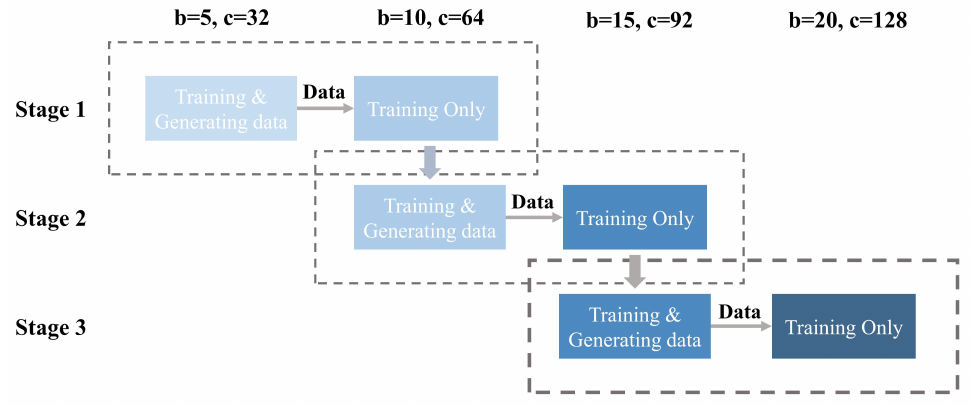
Figure 5. Process of network curriculum learning. Data generated by the shallower network are used to train both the shallow network itself and a deeper network. The whole process contains three stages, and the network with b = 20, c = 128 was extracted as the final network that is used in the